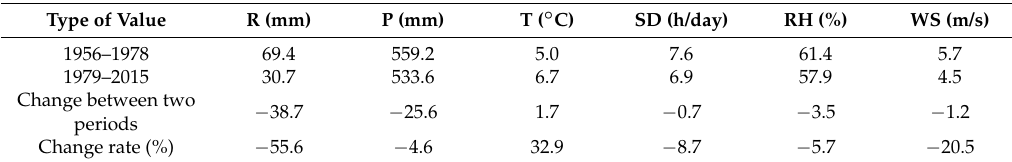
Table 4. Variations in annual R and climatic elements between the two